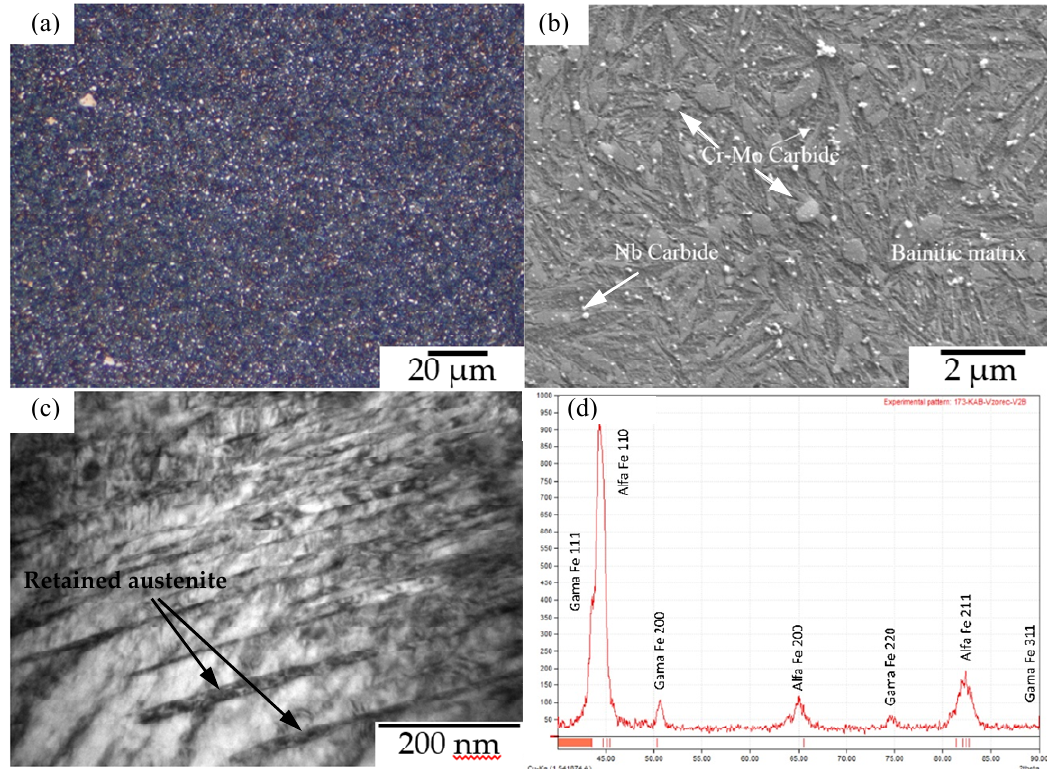
Figure 2. Initial microstructure and corresponding rentnogram of heat treated SIHARD S250 STEEL; spectrum.